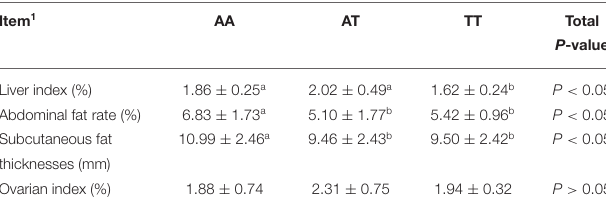
TABLE 2 | Effects of the T329S mutation on organ indices in